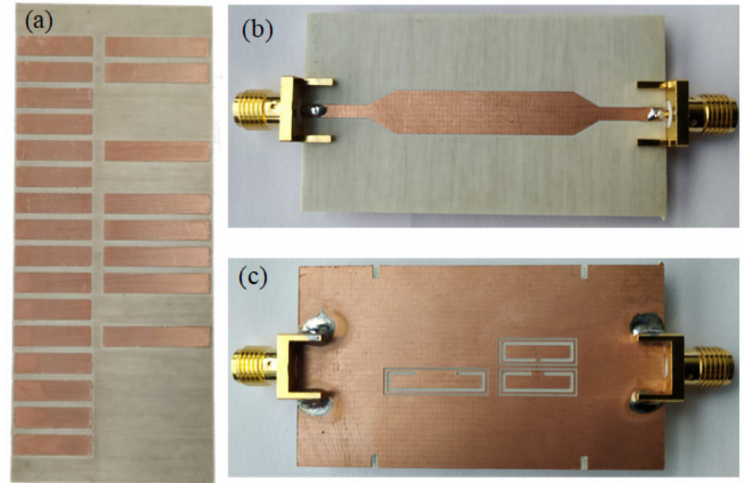
Figure 26. Photograph of the fabricated encoder ( a ) and top ( b ) and bottom ( c ) view of the reader. The ID code of the encoder is “1100-1011-1101-0000”. Reprinted with permission from [28]. Copyright 2020 IEEE.